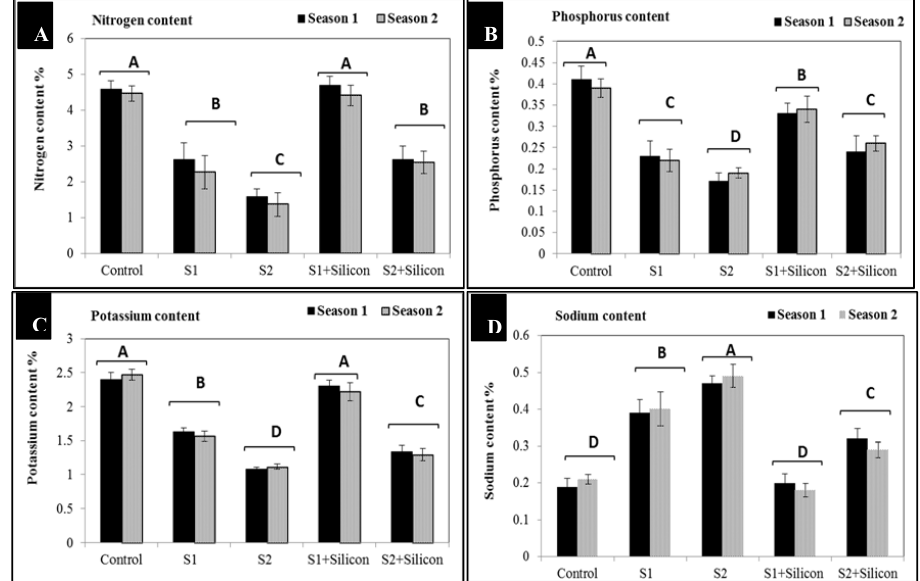
Figure 5. Effects of silicon on nitrogen ( A ), phosphorus ( B ), potassium ( C ), and sodium ( D ) contents in salt ‐ stressed sweet pepper plants in the 2018 and 2019 seasons. S1: Salinity at 1500 ppm, S2: Salinity at 3000 ppm.